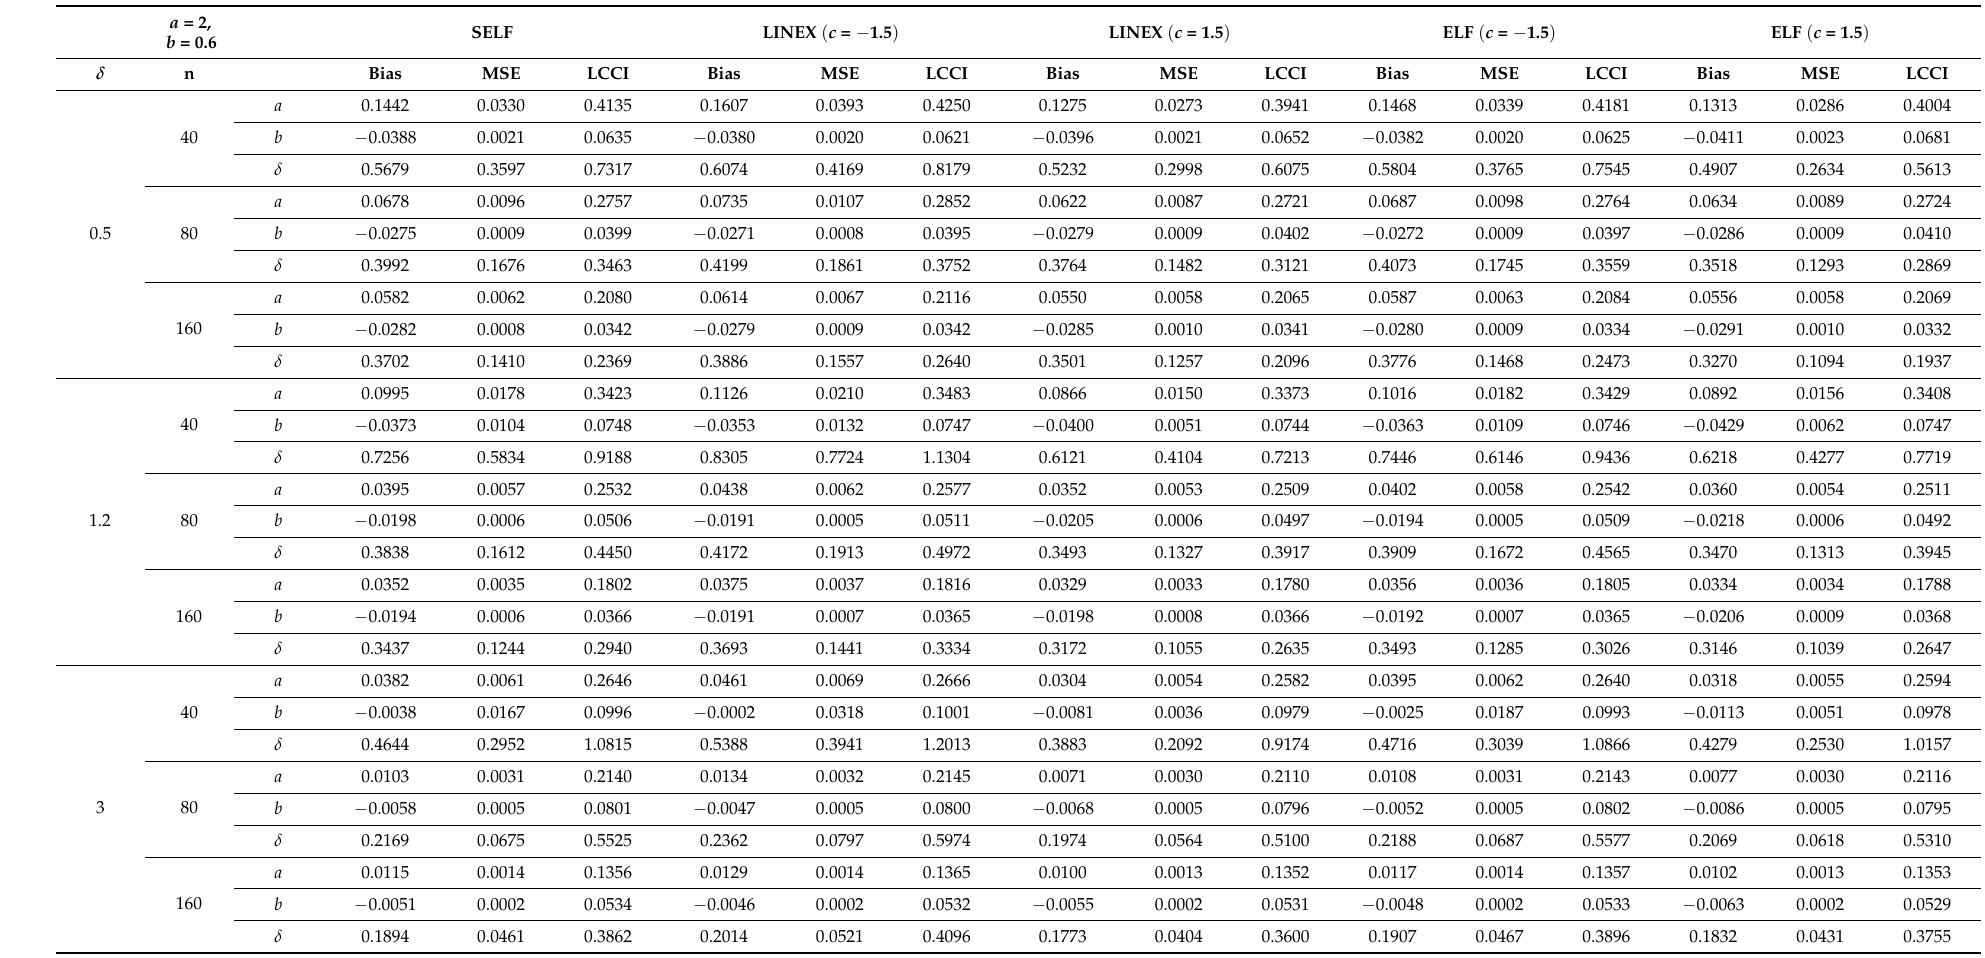
Table 5. Bayesian inference with different loss functions when a = 2, b =